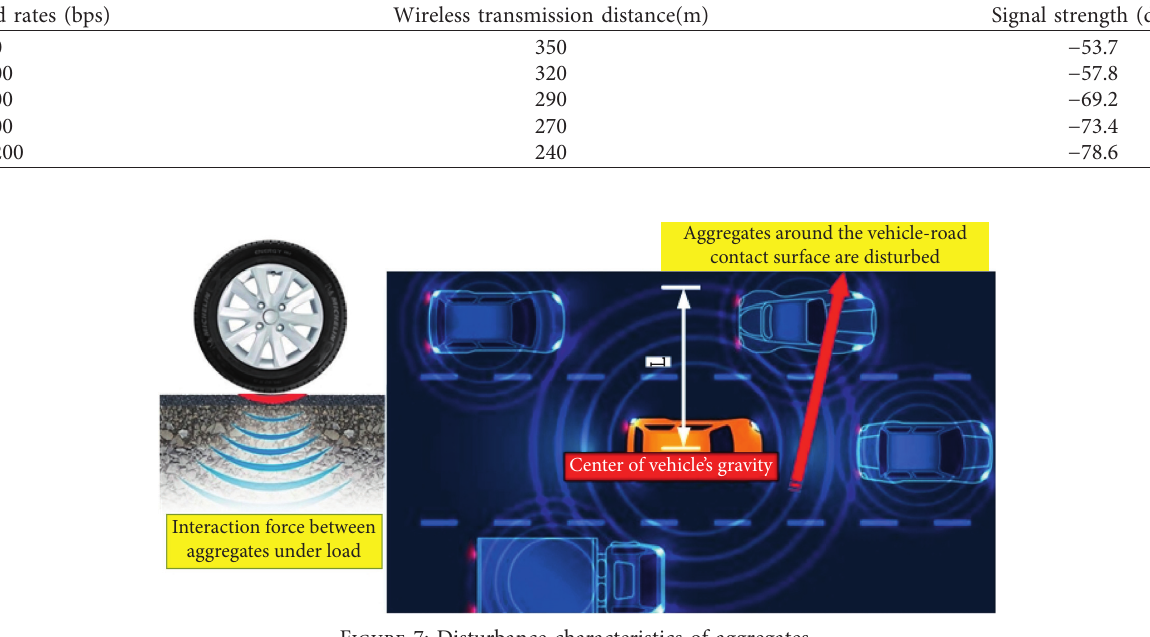
Figure 7: Disturbance characteristics of aggregates.